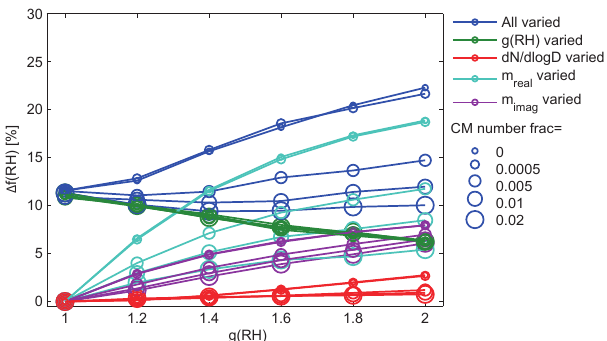
Fig. A1. Relative error 4 f (RH) of the calculated scattering en- hancement using Monte Carlo simulation. The simulations were performed for different hygroscopic growth factors g (RH) ( x axis) and coarse mode number (CM) fractions (circle size). The simula- tions were repeated while keeping one of the individual input pa- rameters constant (see